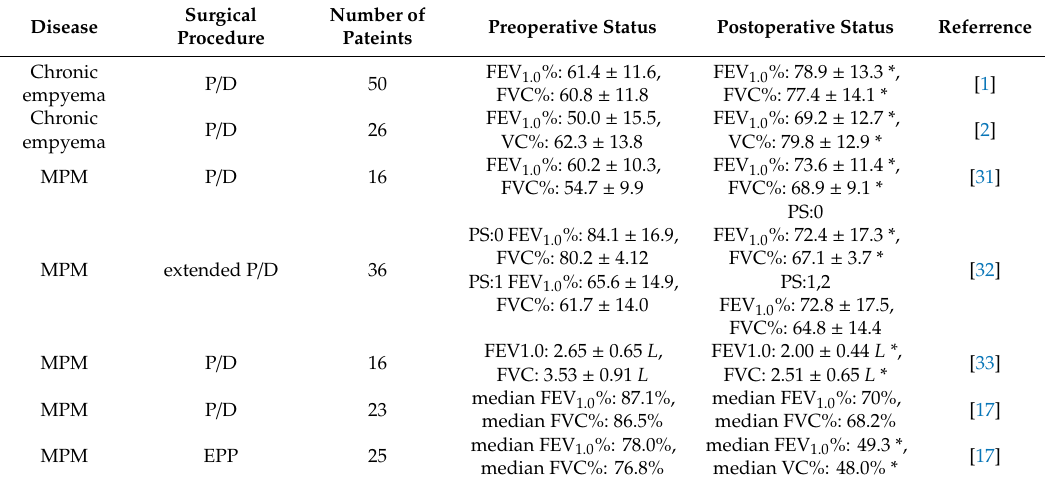
Table 4. Summary of changes in the postoperative pulmonary